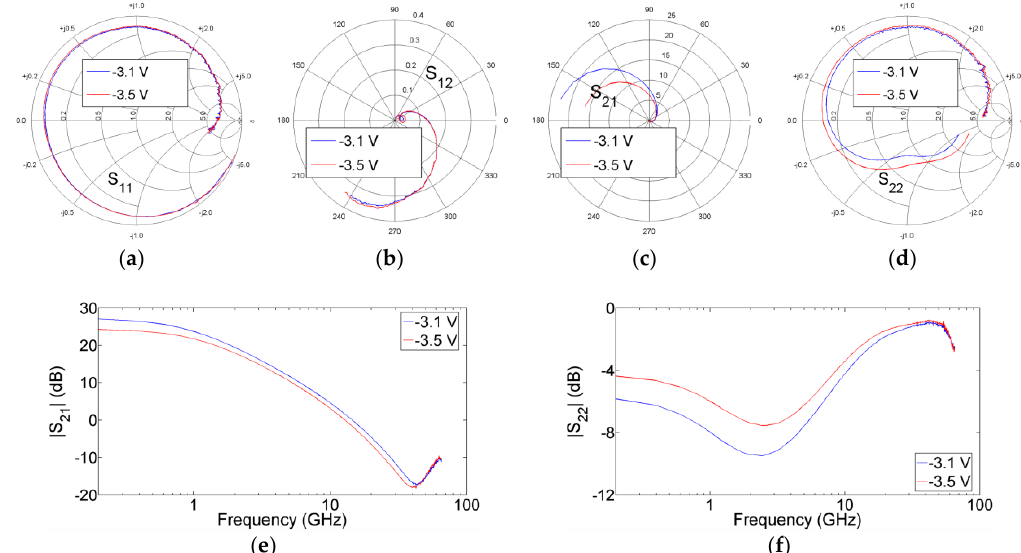
Figure 3. Measured ( a ) S 11 , ( b ) S 12 , ( c ) S 21 , ( d ) S 22 , ( e ) magnitude of S 21 , and ( f ) magnitude of S 22 from 0.2 to 65 GHz for a GaN HEMT at V DS = 30 V and V GS = −3 .1 V under four ambient temperatures: 35 °C, 90 °C, 145 °C, and 200 °C.